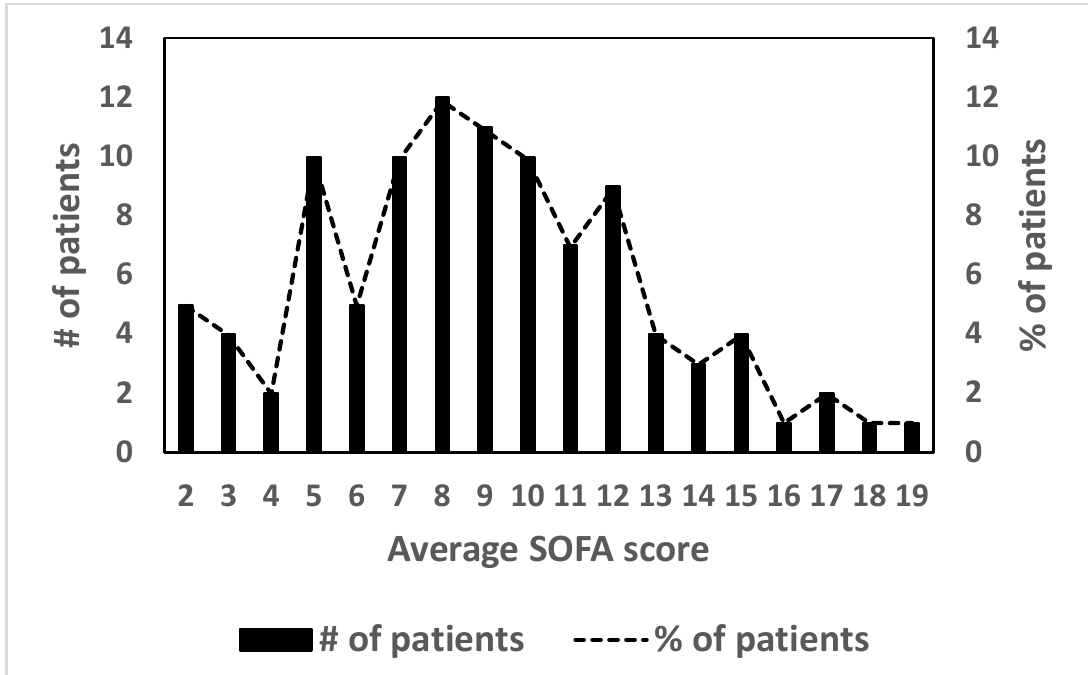
Figure 2. Distribution of patients with severe malaria according to the average Sequential Organ Failure Assessment (SOFA) score of the population studied ( n = 101). Table 3. Life-support techniques used in hospitalized patients with severe malaria. Life-Support